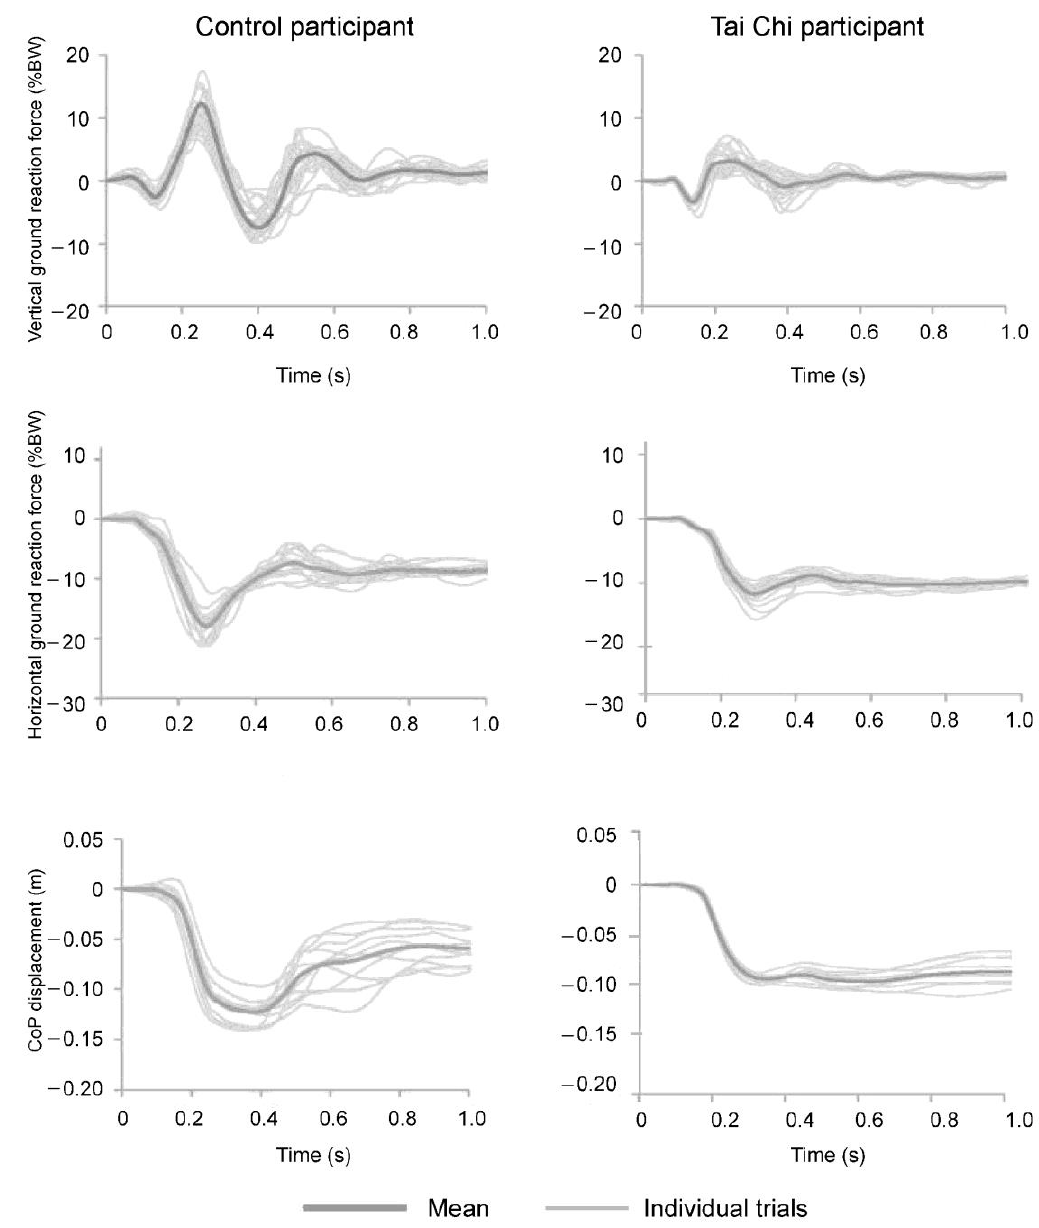
Figure 2. Results of two representative subjects from the control group (left) and Tai Chi (right) group for responses in vertical (top) and horizontal (middle) ground reaction forces and center of pressure displacement (bottom).